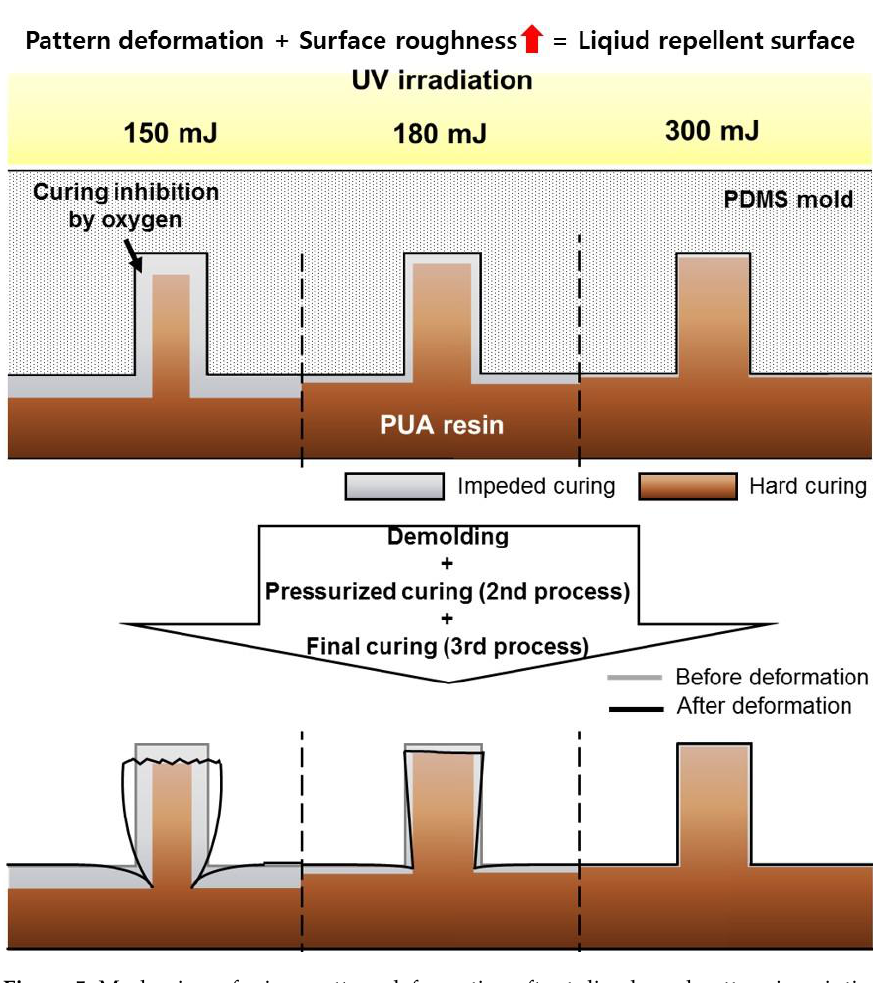
Figure 5. Mechanism of micro-pattern deformation after tulip-shaped pattern imprinting process.